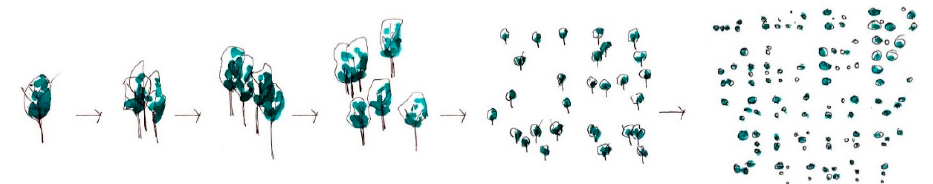
Figure 1. The scales of inquiry in urban green design interventions discussed in this paper range from the individual unit to the neighborhood scale. 1: Tree, 2: Grove, 3: Street, 4: Neighborhood park, 5: Block, 6: Experiential neighborhood.